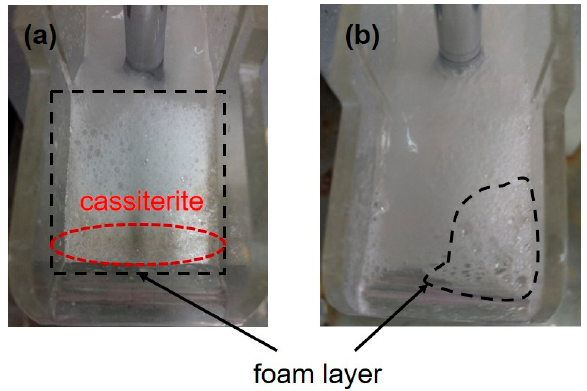
Figure 4. Grade and recovery of cassiterite in mixed binary minerals as a function of CMC concentration.